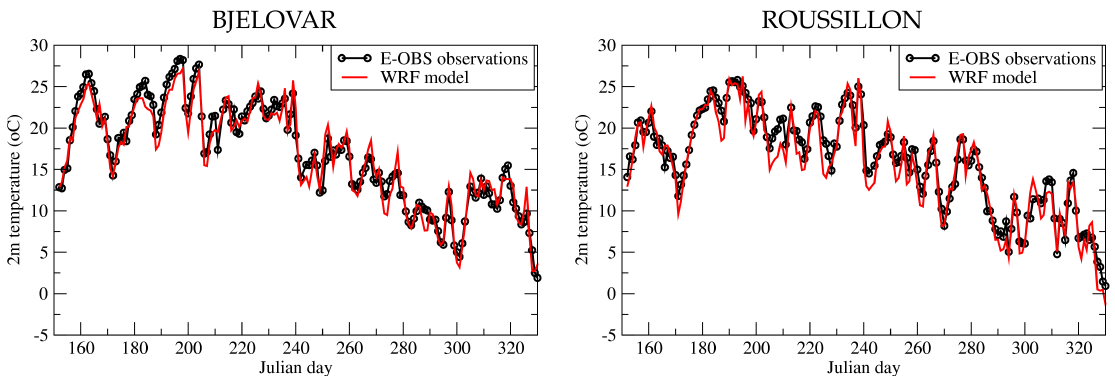
Figure 1. Time series of observed (E-OBS) and modelled (WRF) 2 m temperature for the sites of BJELOVAR and ROUSSIL- LON and for the period ranging from the 1st June to the 30 November